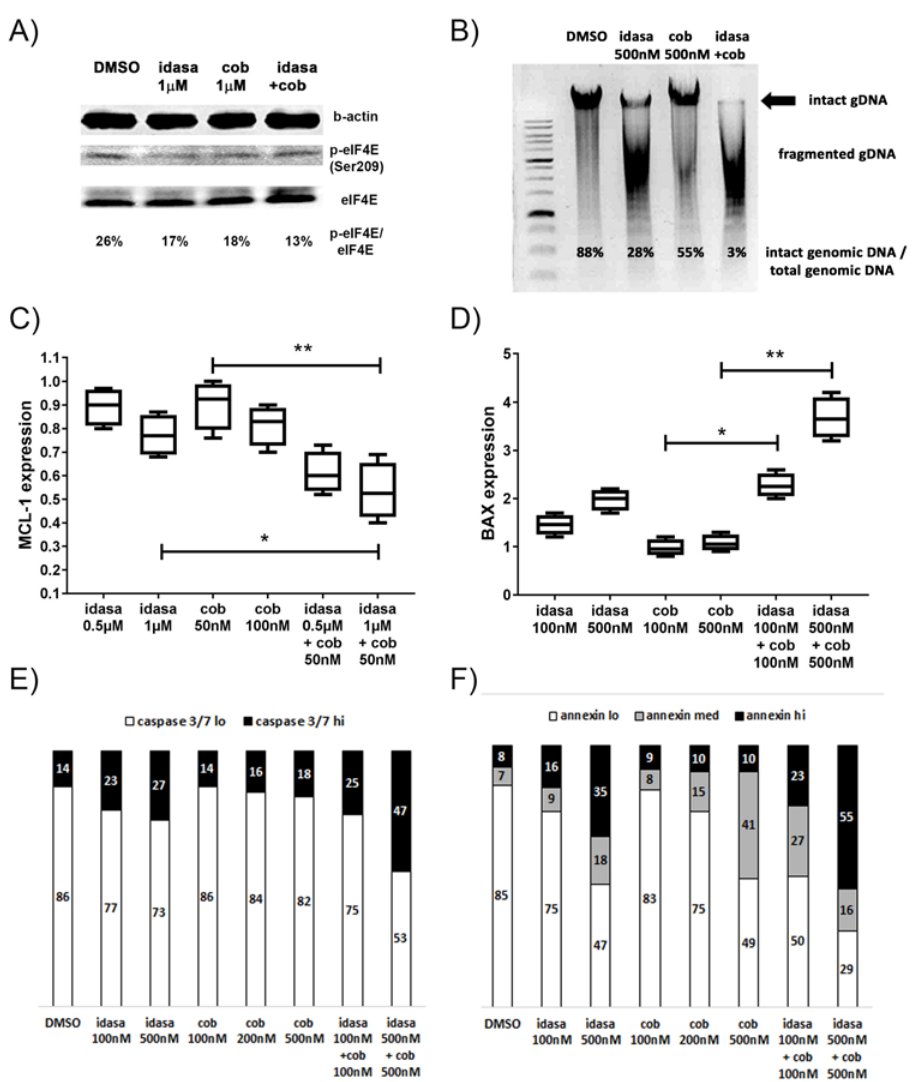
Figure 3. Induction of apoptosis in AML cells treated with idasanutlin and cobimetinib. Reduced levels of activated translation initiation factor phospho-eIF4E ( A ), induction of apoptotic DNA fragmentation ( B ), reduced mRNA levels of the apoptosis inhibitor MCL1 gene ( C ), induced mRNA levels of the pro-apoptotic BAX gene ( D ), induced caspase 3/7 activity ( E ), increase in annexin positive apoptotic MOLM-13 cells ( F ) treated with the indicated amounts of idasanutlin (idasa) and cobimetinib (cob). Cells were grouped into viable (annexin lo), early apoptotic (annexin med), and late apoptotic (annexin hi) cells. Significance is denoted for p < 0.05 (*); p < 0.005 (**).